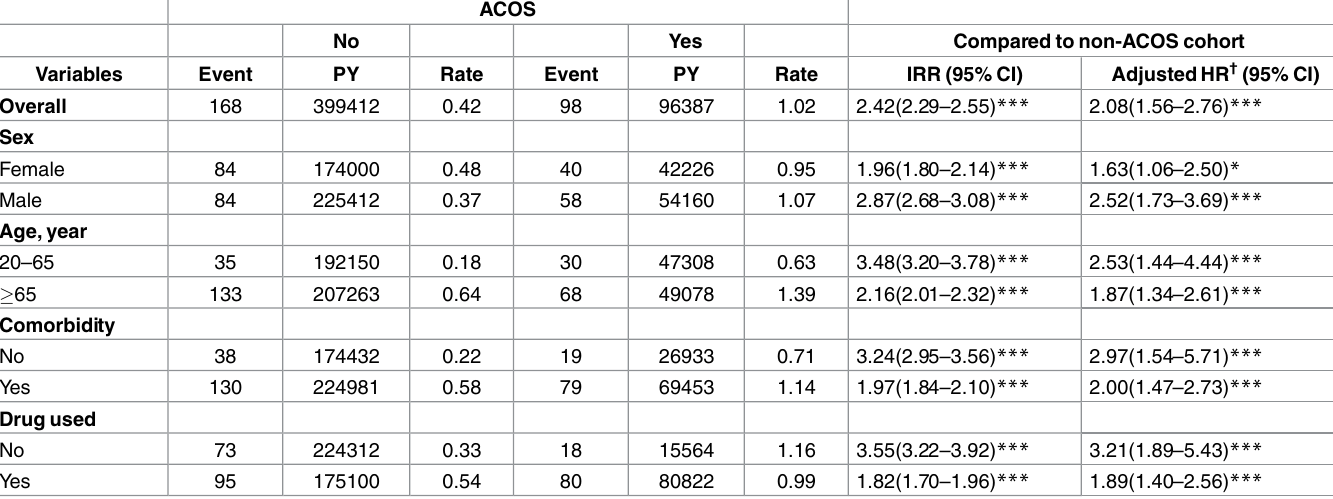
Table 2. Incidencerate and adjusted hazard ratioof pulmonary embolismbetweenACOS and non-ACOS cohorts stratified by sex, age,comorbid- ity (no/yes),and drugused